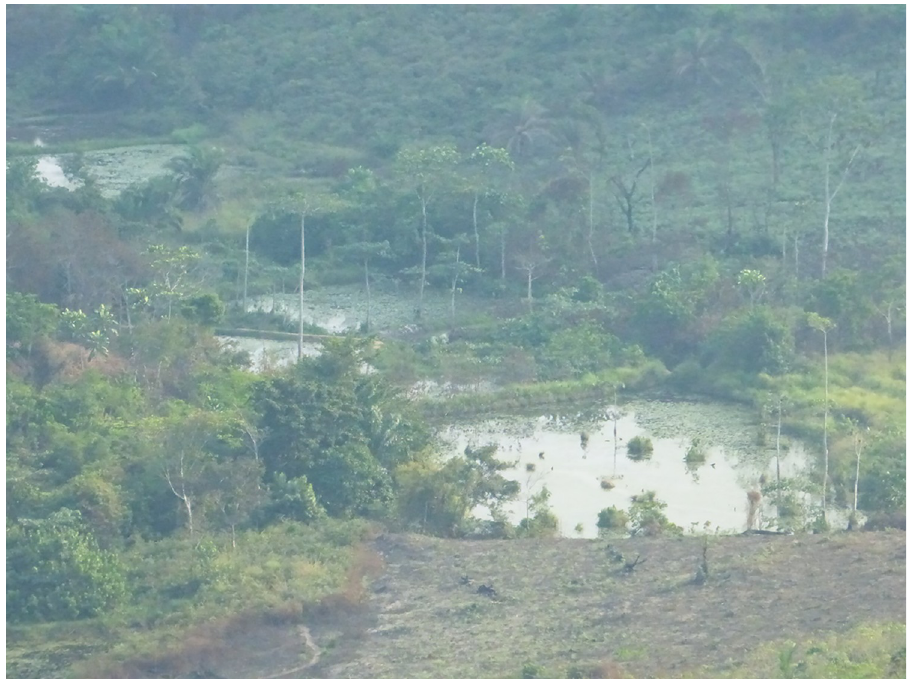
Fig 4. Human-Made Fishponds in Yasa Bonga Health Zone. (Credit: CVK).